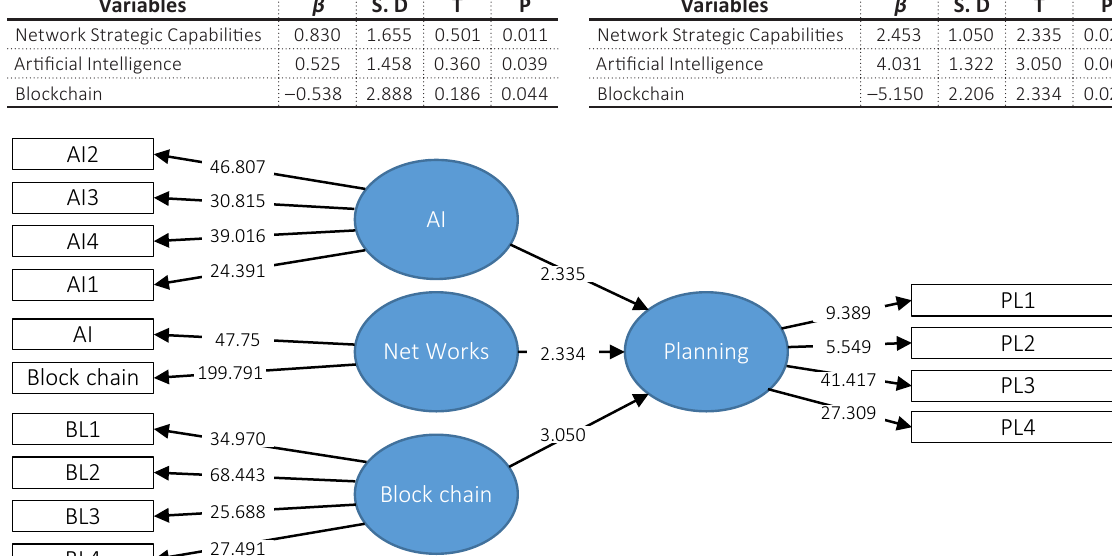
Figure 4. Employing network strategic capabilities on strategic